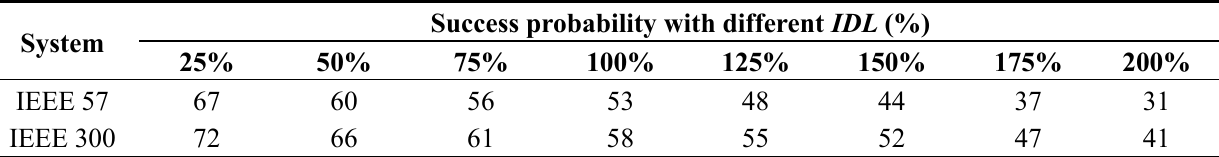
Table 1. Success probability to find a tolerable false data injection (TFDI) attack. IDL : injected data levels; and IEEE: the Institute of Electrical and Electronics Engineers.